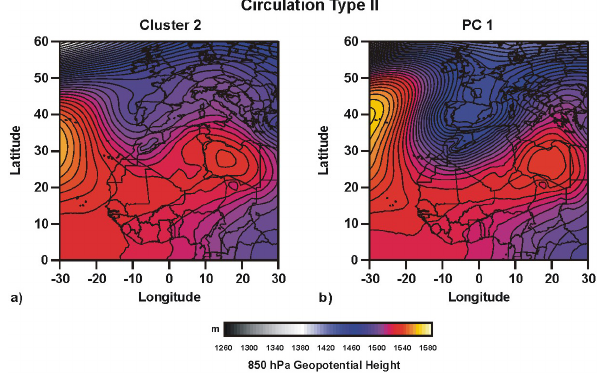
Figure 2. Composite 850hPa geopotential height (m) representing circulation type I leading to ADO over the western Mediterranean Basin.